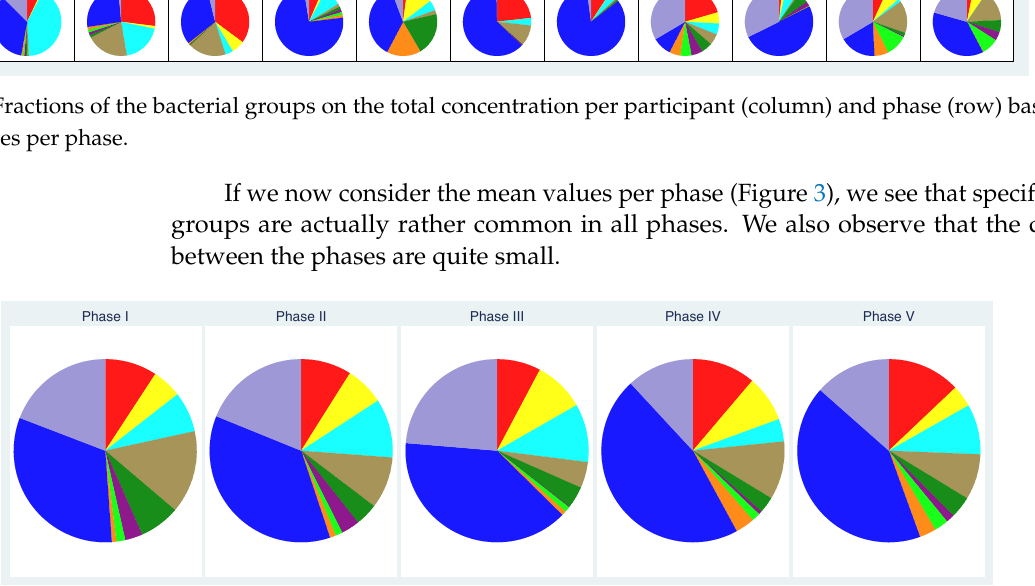
Figure 3. Fractions of the bacterial groups on the total concentration per phase based on mean values per